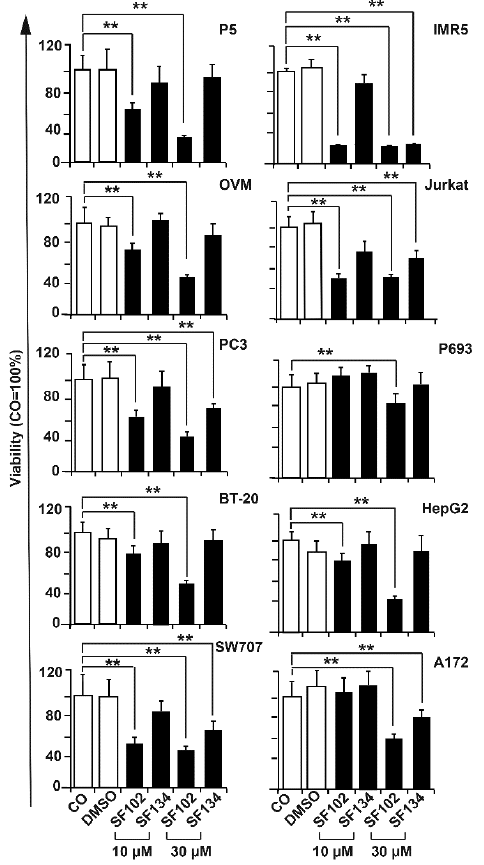
Figure 3. SF102 and SF134 repress viability in various cancer entities. Ovary (OVM), prostate (PC3), breast (BT- 20), colorectal (SW707), glioblastoma (A172), hepatocellular (HepG2), neuroblastoma (IMR5), and T cell leukemia (Jurkat) cell lines were treated with SF101 or SF102 in concentrations of 10 µM and 30 µM. After 24 h, the viability was measured by MTT assay. DMSO served as a vehicle control. Data are means ±SD of at least three independent experiments. * p < 0.05, ** p < 0.01.